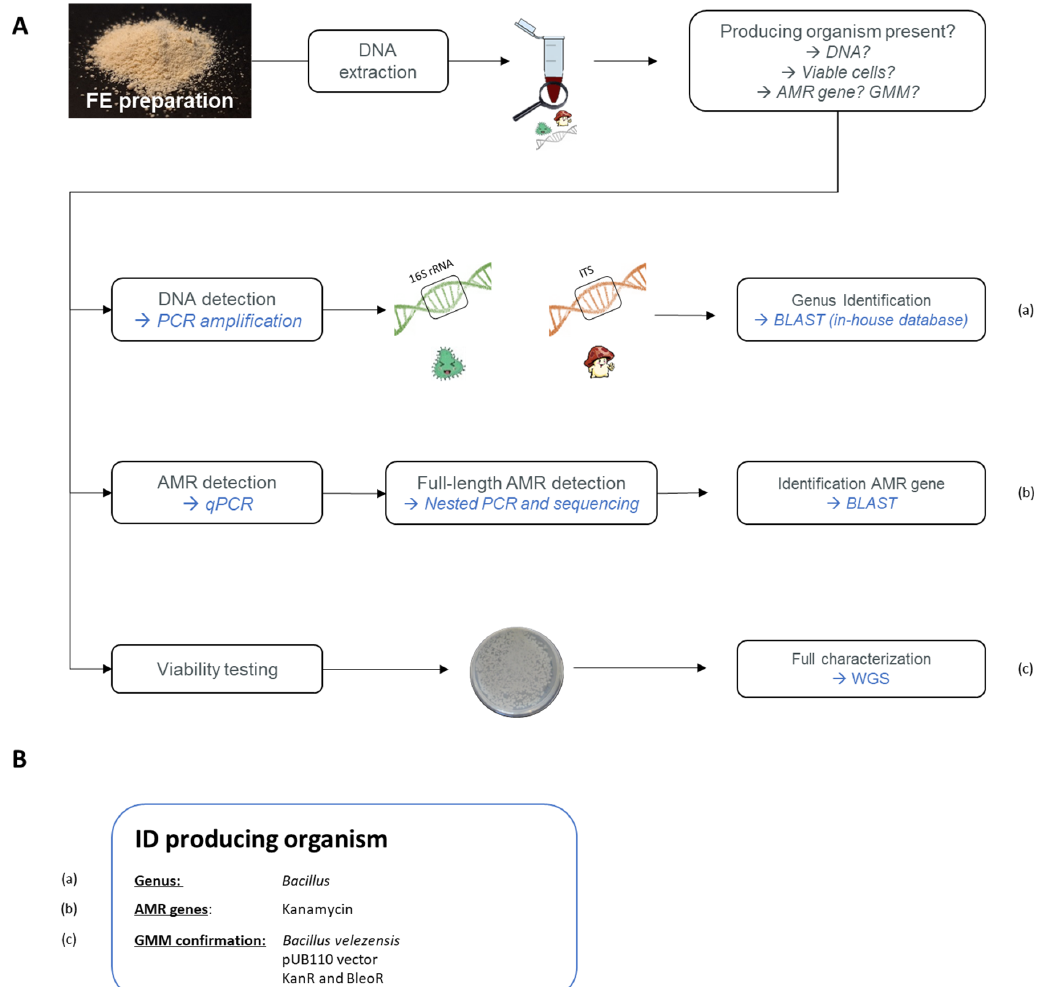
Figure 4. ( A ) General overview of a developed strategy targeting the unexpected presence of FE-producing micro-organisms, with special attention given to GMM strains. (a) First, by targeting the 16S rRNA sequence and the internal transcribed spacer (ITS) region, the potential presence of bacterial and fungal DNA, respectively< can be detected. Identification of an amplicon is obtained by sequencing followed by blasting against in-house databases. (b) The presence of antimicrobial resistance (AMR) genes is targeted using qPCR amplification. If a positive signal is obtained, the full length of the gene is amplified using a nested PCR and then sequenced. The identification of detected AMR genes is verified by blasting. (c) As an additional analysis, a viability assessment is performed. If colonies are obtained, first the two above methods are repeated to confirm the previously obtained results and to select GMM colonies if AMR genes have been detected. A full characterization can consequently be obtained by whole-genome sequencing (WGS) of the obtained colonies. The genetic modifications can be characterized and the identity of the GMM can be demonstrated. ( B ) Using the strategy shown in ( A ), a detected micro-organism can be identified. Here, the example of the GMM-producing protease (RASFF2019.3332) is